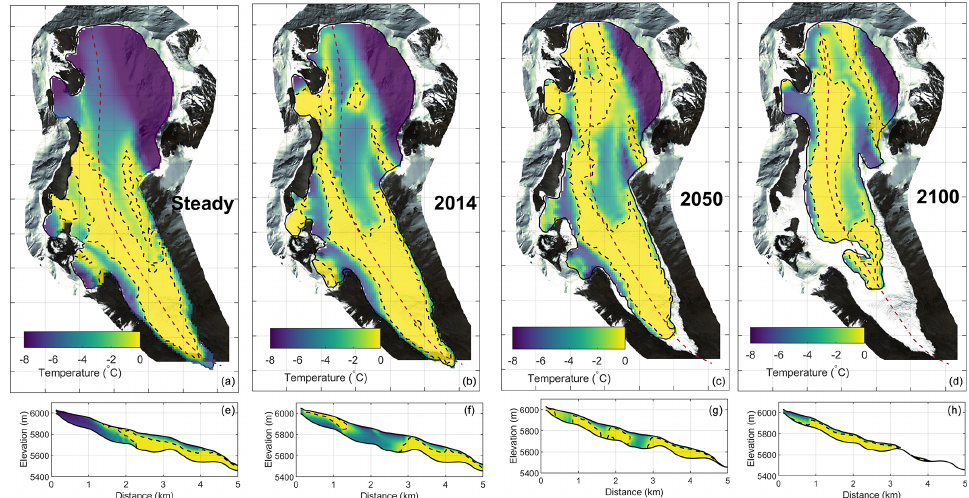
Figure 11. Future evolution of Rikha Samba Glacier assuming a linear temperature increase of + 1 ◦ C between 2014 and 2100 ( + 1 . 7 ◦ C in comparison with the steady-state climatic condition). Panels (a) – (d) represent basal temperature evolution. Panels (e) – (h) are temperature evolution along the middle longitudinal section. Black dashed lines delimit the cold–temperate transition